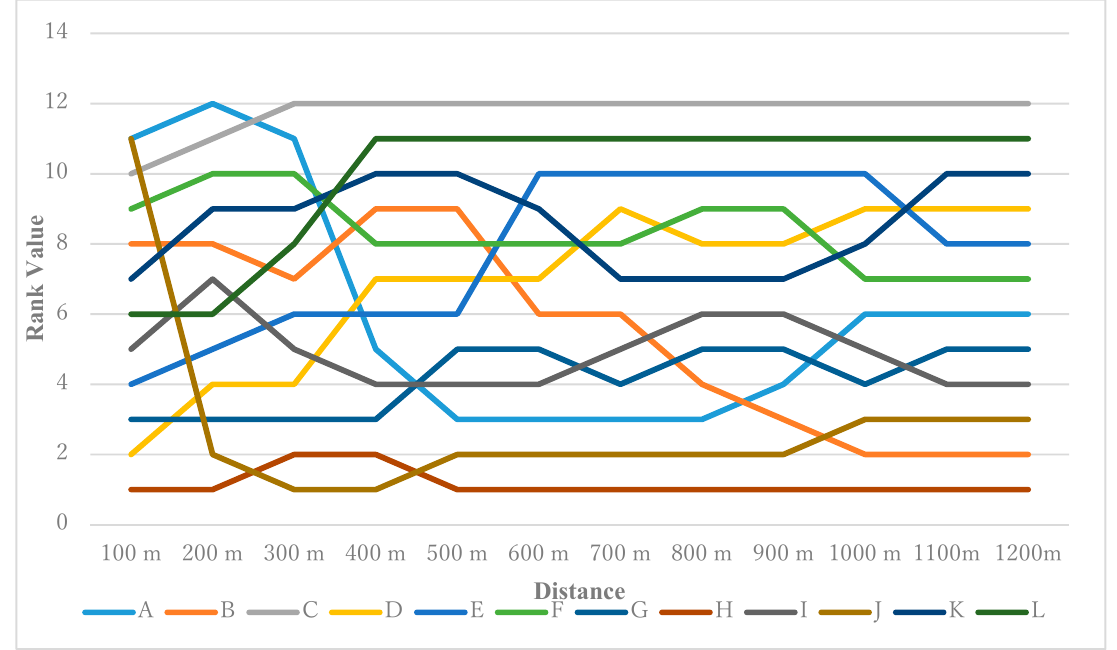
Figure 10. Ranking fluctuation of each candidate facility by different distances.